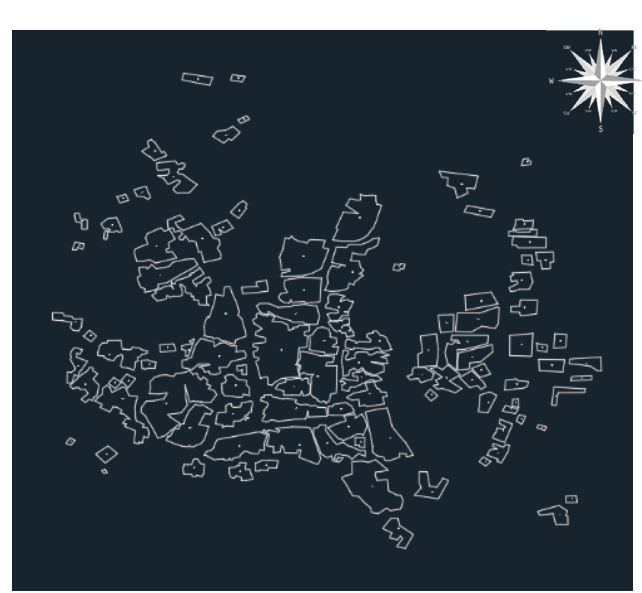
Figure 7. Total area of the buildings in the village, which is calculated as 75,156 square meters. Table 1. Sample building specifications.